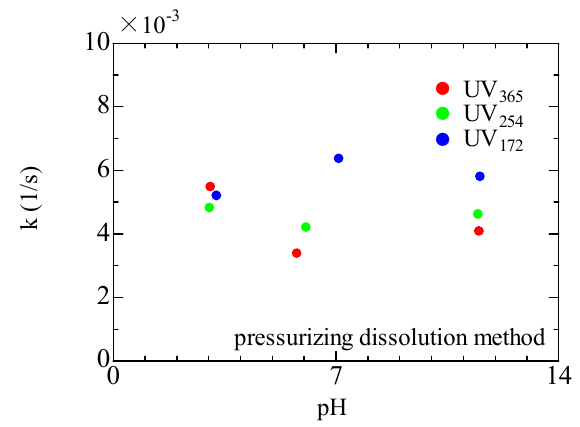
Fig. 13 Effect of UV wavelength on the reaction rate constant for various solution